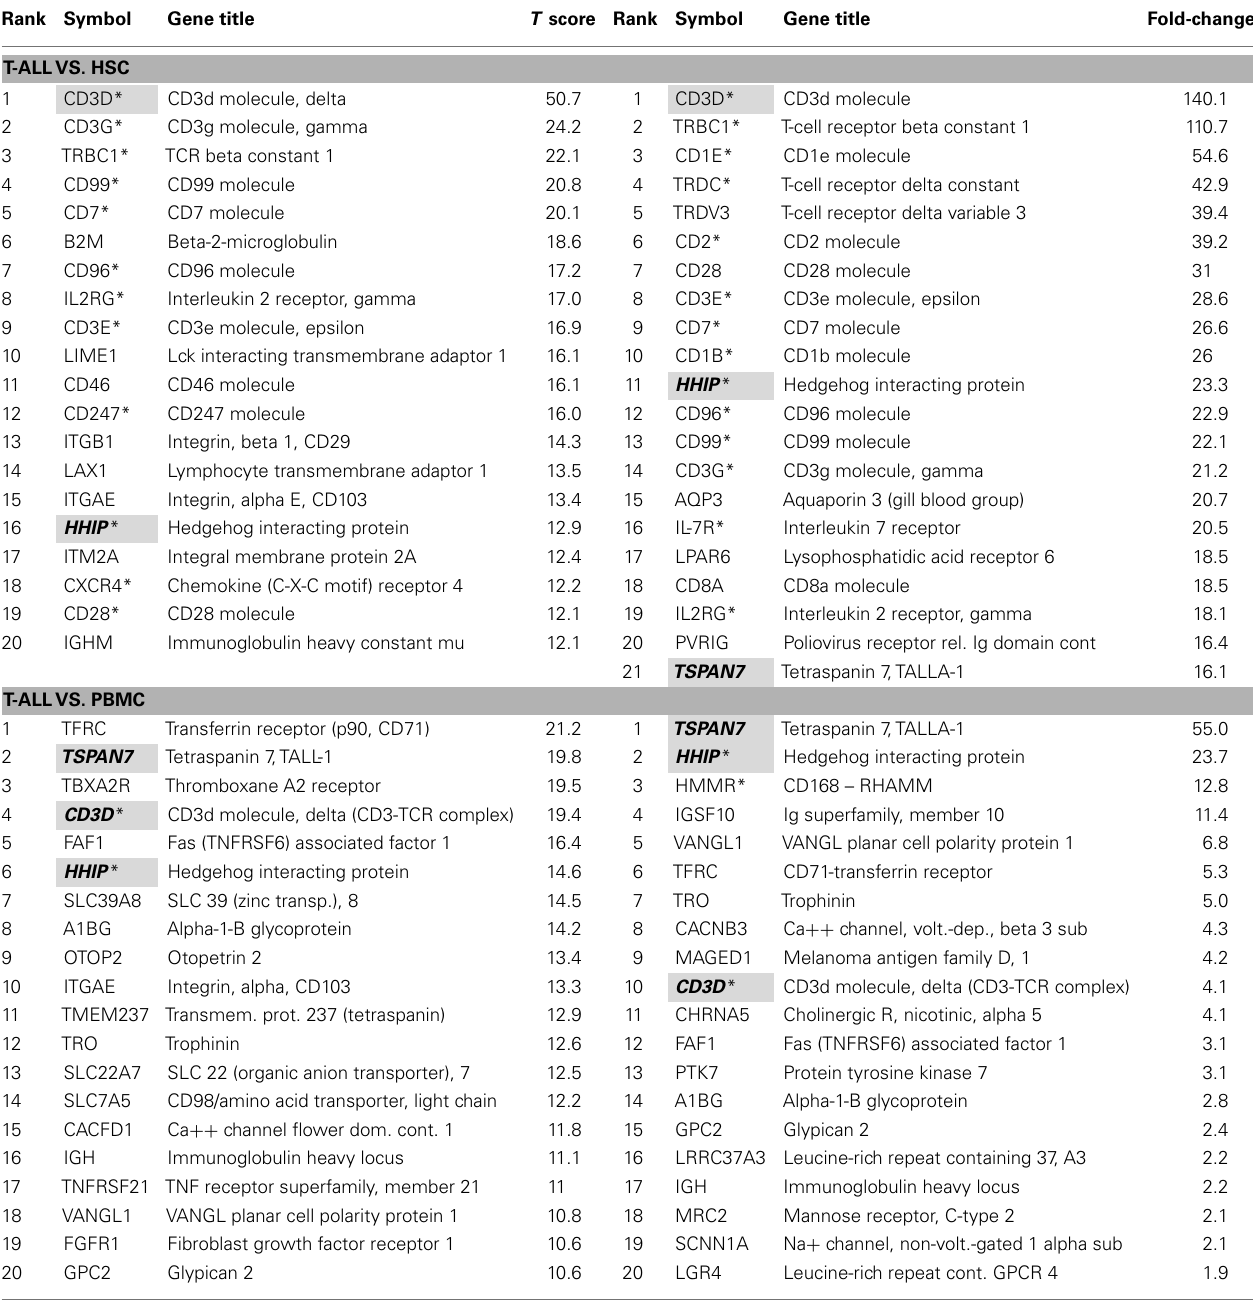
As for Table 2 ,T-ALL gene expression profiles were compared to either CD34 ( + ) HSC (top half of table) or PBMC (bottom half of table). Data are reported and ranked according toT score (left half of table) or fold-change (right half of table). Both Gene Symbol and GeneTitle are given for each transcript.Those transcripts that are represented in Table 2 (where comparison was to an array of normal tissues) are followed by an asterisk in the Gene Symbol column.Those transcripts appearing in both the top and bottom half of the table are in bold, with gray